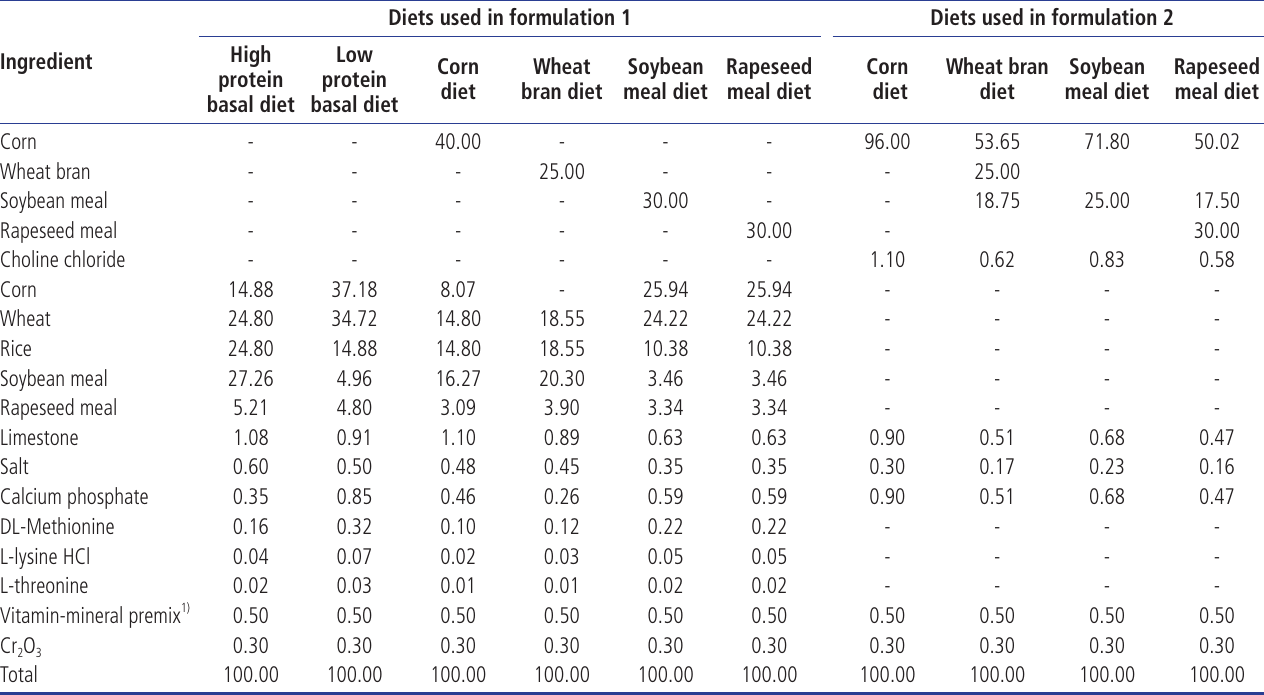
Table 1. Ingredient composition of the experimental diets (% as fed basis)